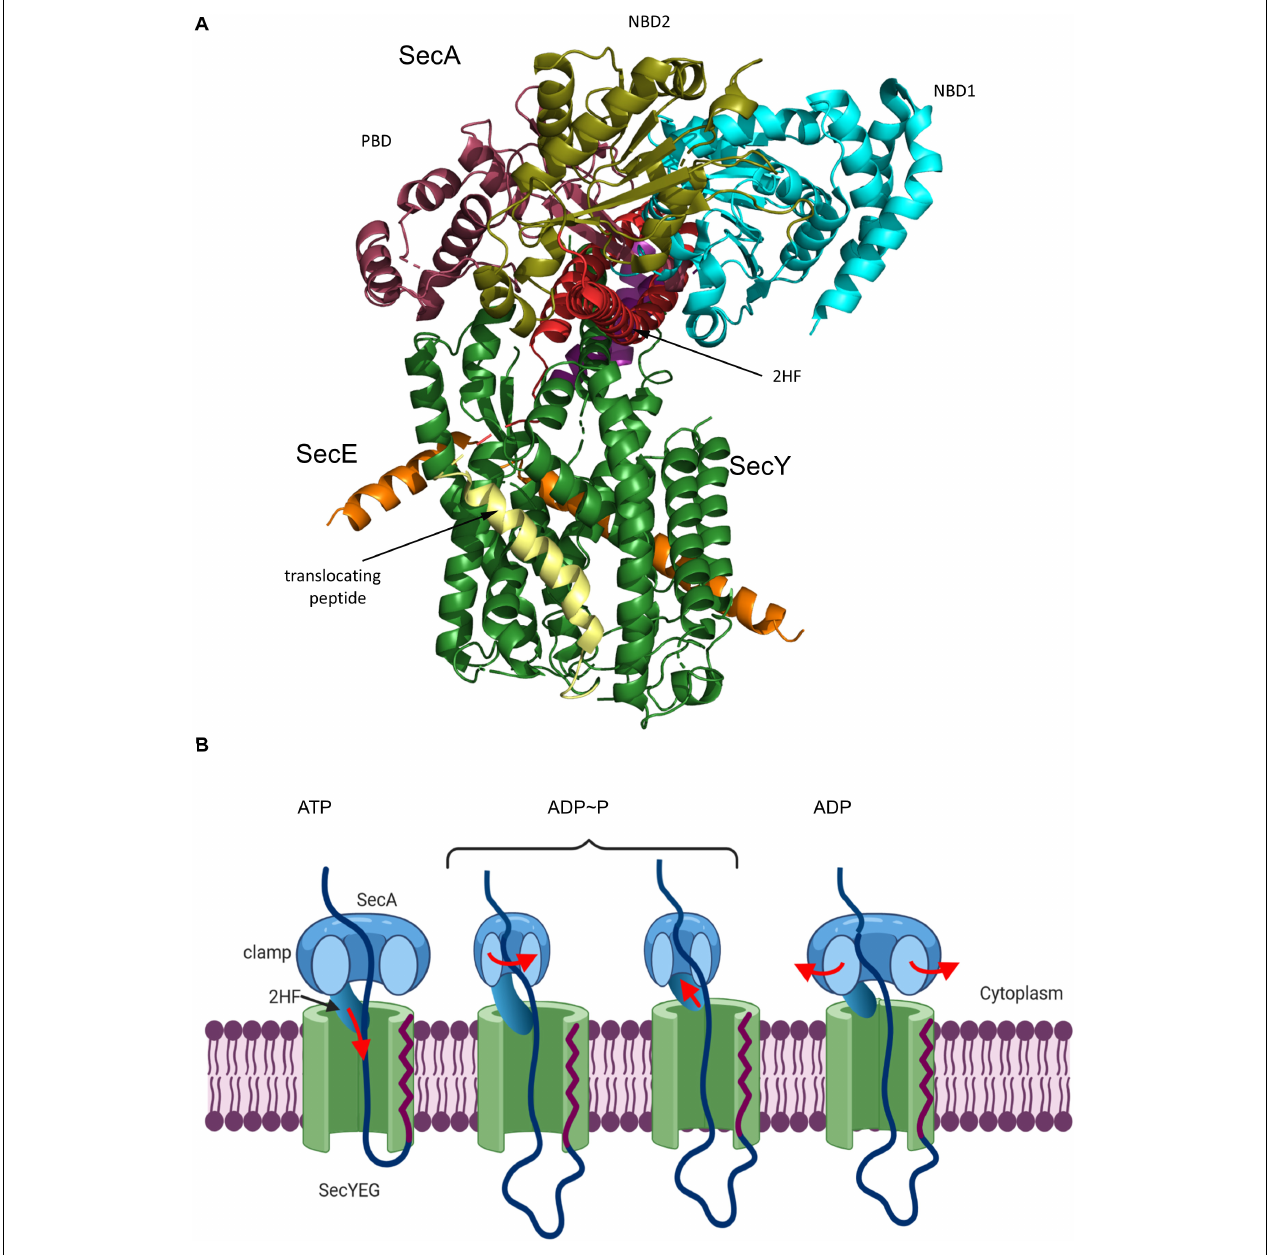
FIGURE 7 | Structure of the substrate-engaged SecA-SecYEG complex and model for SecA-dependent translocation across the SecYEG-translocon. (A) Structure of the SecA-SecYEG complex from B. subtilis (PDB 5EUL). SecY and SecE are shown in green and orange, respectively, and the translocating peptide in yellow. The different domains of SecA are indicated. 2HF corresponds to the two-helix finger. (B) Upon ATP binding to SecA, the 2-helix-finger (2HF) inserts into the SecY channel and pushes the polypeptide into the channel. The signal sequence is depicted in red. For preventing back-sliding, the polypeptide binding domain (PBD) of SecA rotates toward the nucleotide-binding domain (NBD2) and forms a clamp that traps the polypeptide. This step likely occurs before or simultaneously with ATP-hydrolysis. Closing the clamp also leads to the retraction of the 2HF. After phosphate release, the clamp opens again and the polypeptide can slide deeper into the channel but in principle also backward. In vivo , backsliding at this stage could be prevented by contacts of the polypeptide to periplasmic chaperones, like Skp (Schäfer et al., 1999) or the PpiD/YfgM complex (Götzke et al., 2014; Jauss et al., 2019). In addition, the membrane potential is likely important for maintaining directionality of translocation (Driessen and Nouwen, 2008; Knyazev et al., 2018). Figure was modified after (Catipovic et al.,